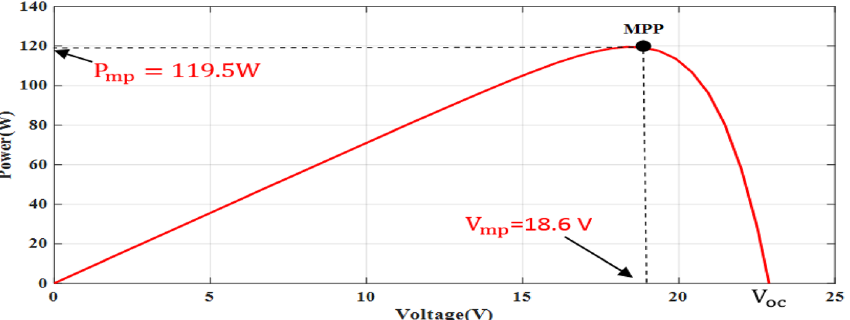
Figure 11. P – V graph of double-diode PV model at STC.